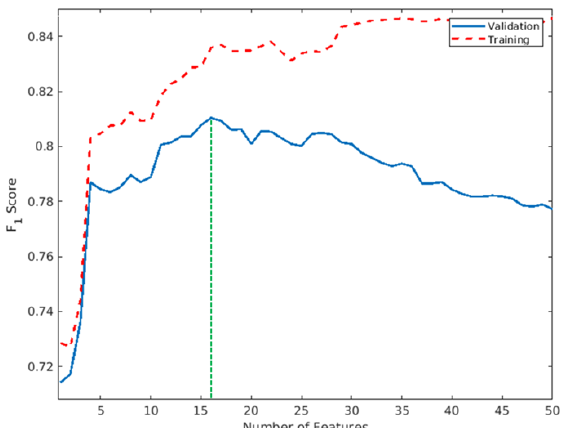
Figure 3. F 1 accessed on 30 October 2019 score obtained on the average training (red dotted line) and validation (blue line) sets during cross-validation performed by SVM after adding different features. The model reached the highest performance on the validation set when using 16 features (green dotted line). Abbreviation: SVM = support vector machine.